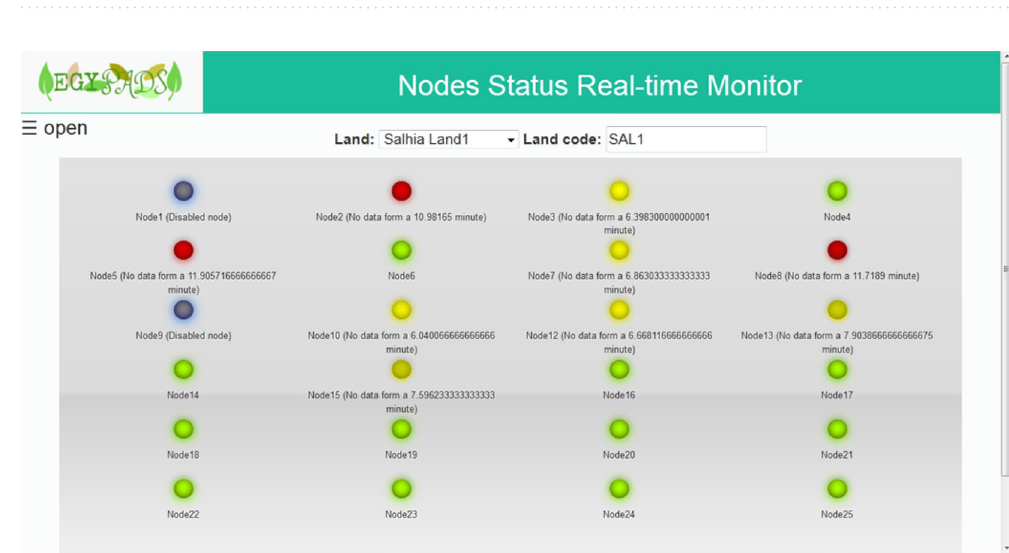
Figure 14. The sensor nodes’ status monitoring